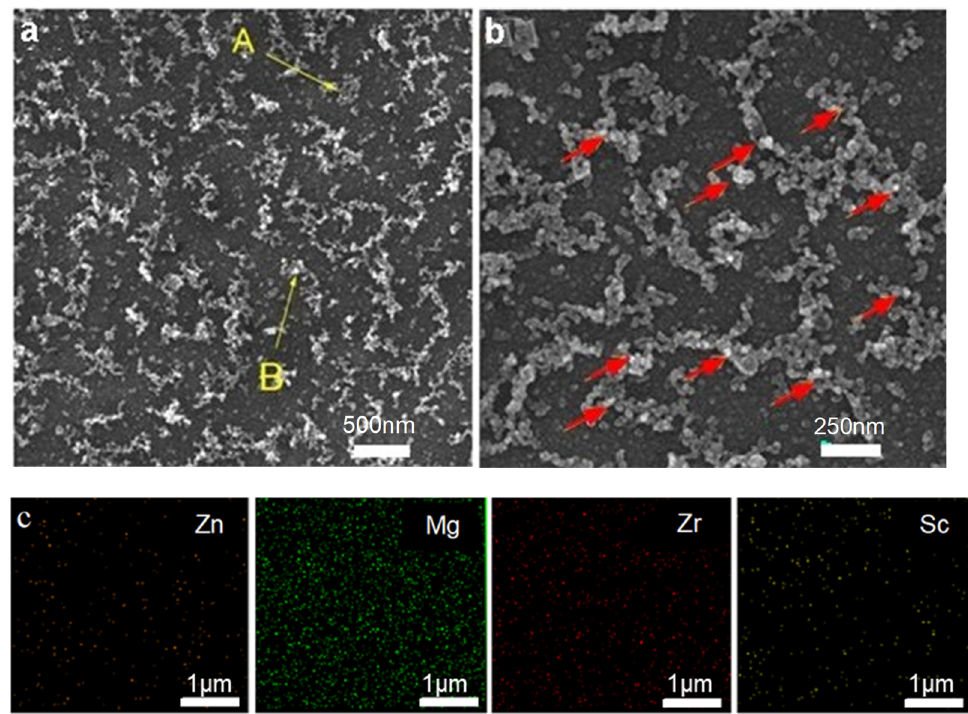
Figure 7. Distribution of MgZn 2 and Al 3 (Sc,Zr) precipitates in Al matrix in alloy under thermomechanical treatment with conventional dissolution and 30% rolling: ( a ) Al 3 (Sc,Zr) and MgZn 2 precipitates, ( b ) distribution of Al 3 (Sc,Zr), and ( c ) element distribution maps.